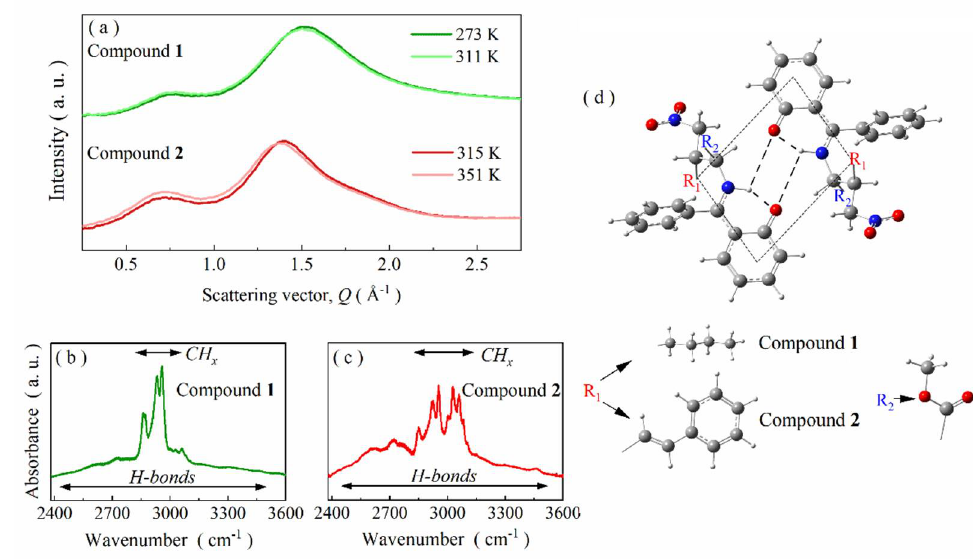
Figure 2. ( a ) XRD patterns collected for melt-quenched glycine imino esters 1 and 2 at various temperatures. ( b ) Room-temperature FTIR spectrum of compound 1 in the H-bonding region. ( c ) Room-temperature infrared spectrum of compound 2 presented from 2400 to 3600 cm −1 . ( d ) DFT-optimized dimeric structure with marked BHBs center.